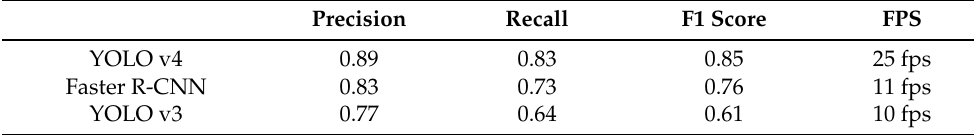
Table 4. Comparison of scores between three object detection